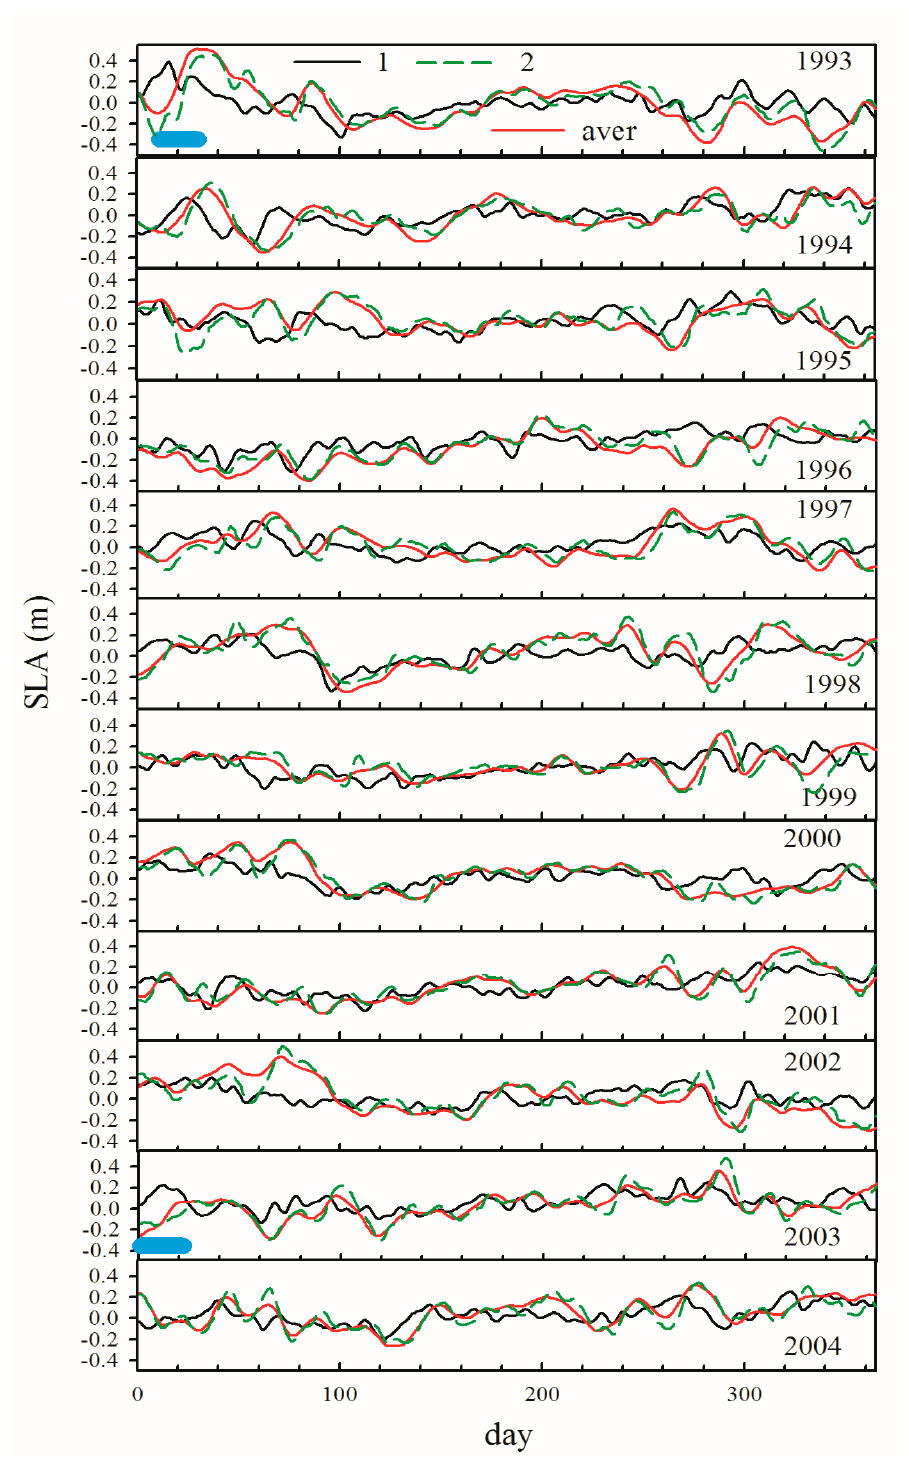
Figure 11. Cont Figure 11. Time series of SLA in years 1993–2017. Data for pixel 1 (North Sea) are shown as a solid black line, for pixel 2 as a dashed green line, and for the mean SLA in the Baltic Sea proper as a red line. Horizontal thick blue lines indicate MBI events. The inflow event during the fall of 2016 has been marked in red, which has not been classified in IOW reports as the MBI.